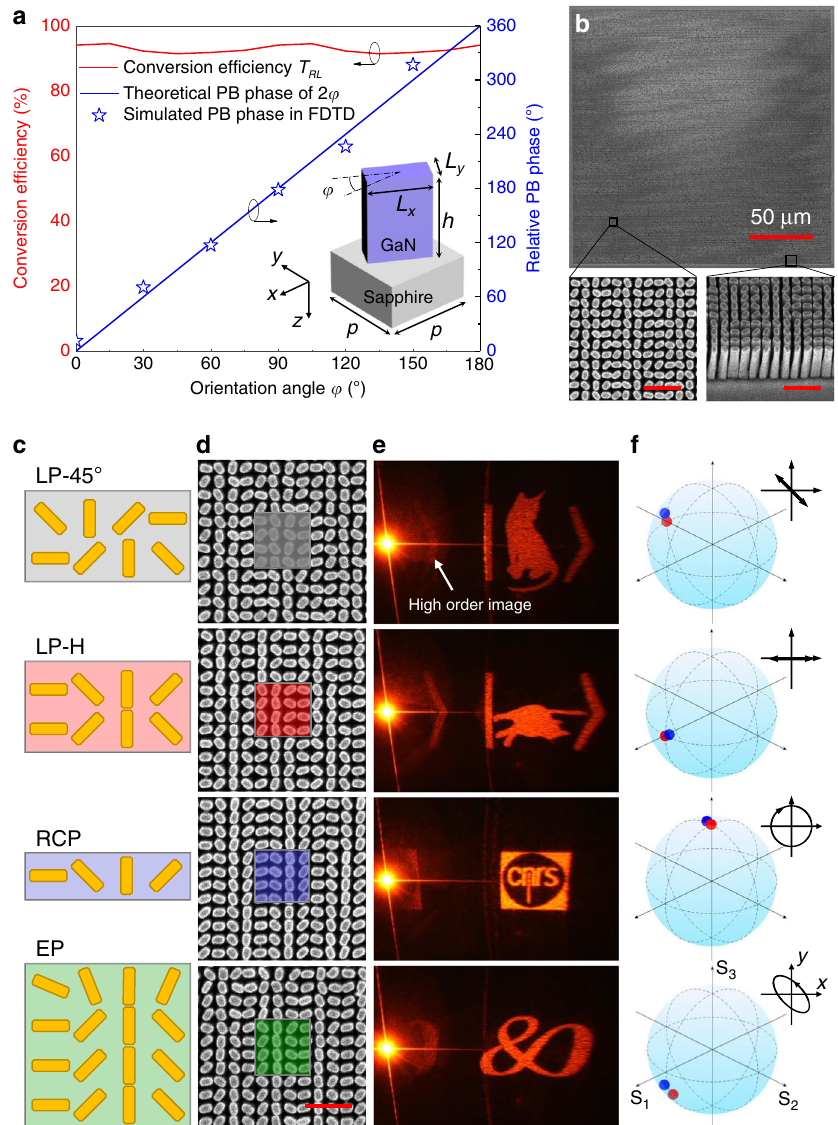
Fig. 2 Realization of polarization-reconstructed meta-hologram. a Simulated results of the CP conversion ef fi ciency and relative PB phase of the metasurface consisting of an array of GaN nano-pillars fabricated on the top of a Sapphire substrate. The inset picture shows the schematic of one unit-cell of the metasurface with dimension of L x = 230 nm, L y = 120 nm, h = 1 μ m, p = 300 nm and various orientation angle φ from 0 to 180°. The incident LCP light is illuminated from the backside. b The scanning electron micrograph (SEM) images of a fabricated meta-hologram, where a top- and tilted-view of enlarged areas in the meta-hologram are presented. The scale bar of the enlarged image is 1 μ m. c Structure con fi guration for the polarization generation of LP-45° ( fi rst row), LP-H (second row), RCP (third row), EP (last row). d SEM images of fabricated results. The scale bar is 1 μ m. e Photographs of the meta- hologram images representing “ alive Schrödinger ’ s cat ” , “ dead Schrödinger ’ s cat ” , “ CNRS logo 1 ” , and “ CNRS logo 2 ” with different SoP. High order image is induced near the central spot. f measured SoP of the corresponded images. The red and blue dots on the Poincaré sphere indicate the designed and measured polarization, respectively. Two Schrödinger ʼ s cats are adapted from